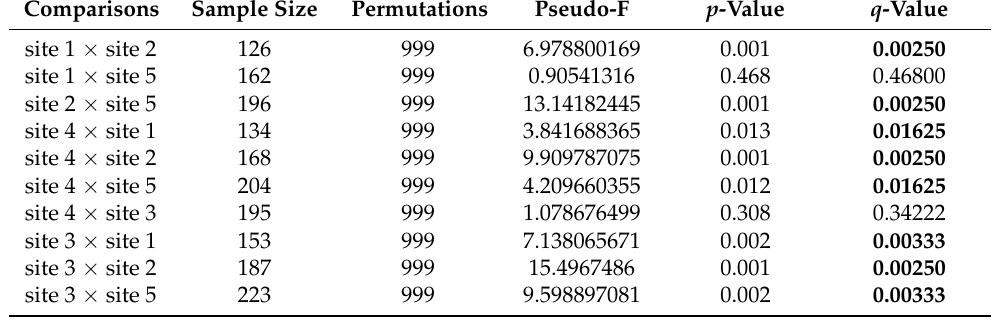
Table 1. Results of PERMANOVA pairwise distances multivariate analysis. Variance of pairwise dis- tance comparisons according to the geographical origin of samples. Values in bold denote statiscrical significance at the q < 0.05 level.